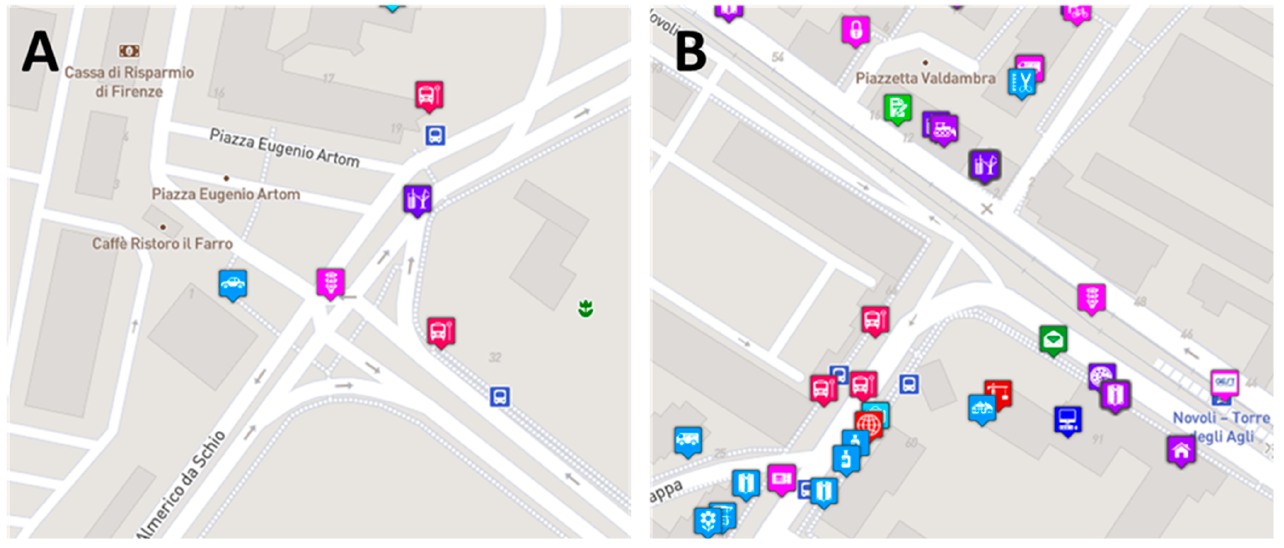
Figure 7. Density of services around stops 𝐀 and 𝐁 .